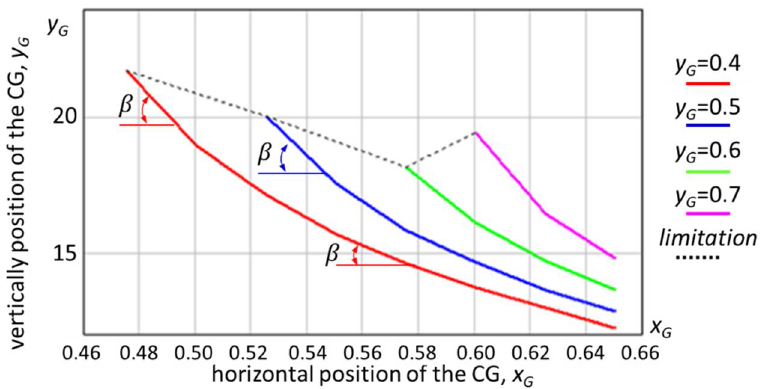
Figure 9. The variation in β [ grd ] as a function of the center of mass for h = 0.20 m (where h is the height of the step obstacle); the height of the step is constant. If the step to be scaled has a different height, the values in the graph will change. The pressure value of the wheel tires was not considered in this